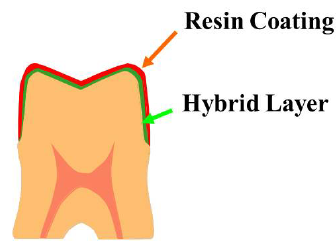
Figure 7. Thin-film coating for sealing the crown